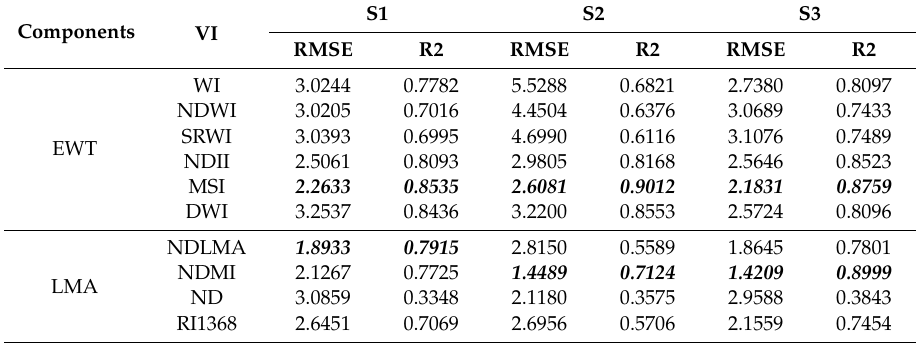
Table 4. Performance of the VI-based models for the estimation of EWT and LMA. The italic bold number gives the best performances under a given sampling